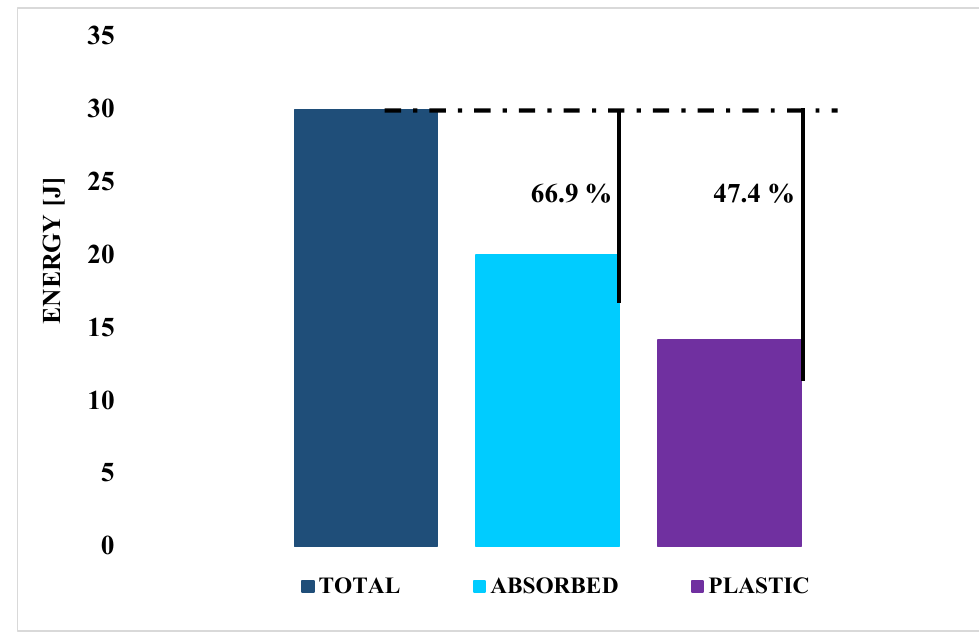
Figure 13. Final simulation of the explosion starting the ejection event: energies histograms.